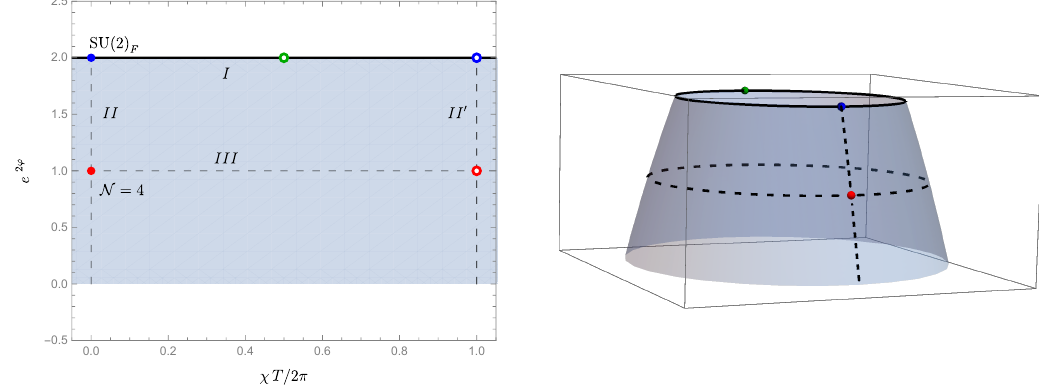
Figure 1 . The large- N holographic CM. The left plot indicates the location of the upper boundary (solid black line), Family I (2.6), along with the (super)symmetry enhanced points: (2.9) in solid ( n 0 = 0 ) and hollow ( n 0 = 1 ) red, (2.10) in solid ( n 0 = 0 ) and hollow ( n 0 = 1 ) blue, and (2.11) in hollow green ( n 0 = 1 ). The dashed lines marked as II and II 0 correspond to Family II, (2.12), at n 0 = 0 and n 0 = 1 , respectively. These two lines are identified per the periodicity (2.5) of χ , rendering the topological cylinder on the right plot. Family III, (2.13), in the interior is also indicated. The locus e 2 ϕ = 0 lies outside the CM and is at infinite distance of the upper boundary w.r.t. the metric